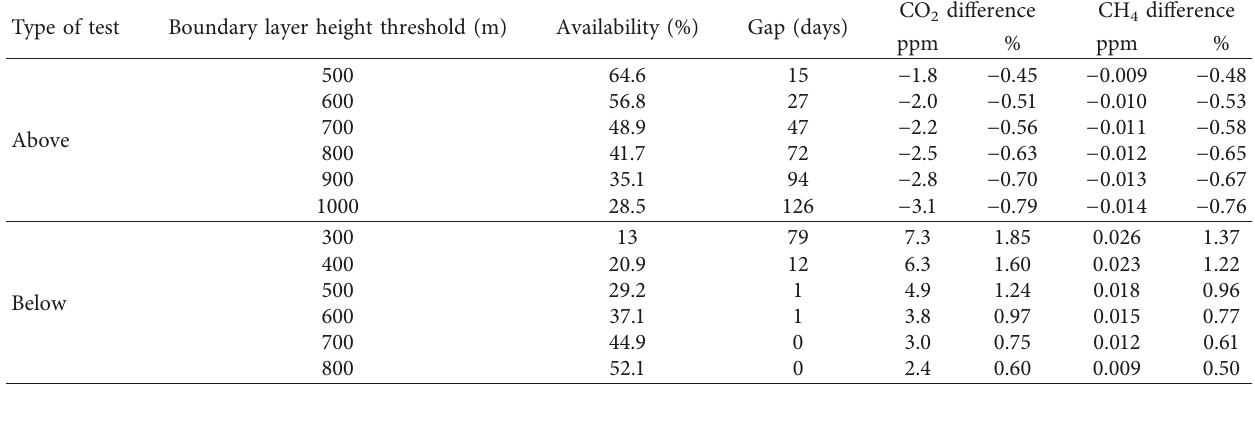
Figure 3: Annual evolution of the boundary layer height (BLH) CO 2 (a) and CH 4 (b) during the day. Three situations were considered: with all the observations (cyan line), for boundary layers below 400m (red line), and for boundary layer heights above 800m (green line). The appearance frequency for the low and high boundary layer is also shown. Table 3: Differences between average concentrations calculated with observations selected for different boundary layer thresholds and the annual cycle for daytime observations. Availabilities and days without observations (gaps) are also included.